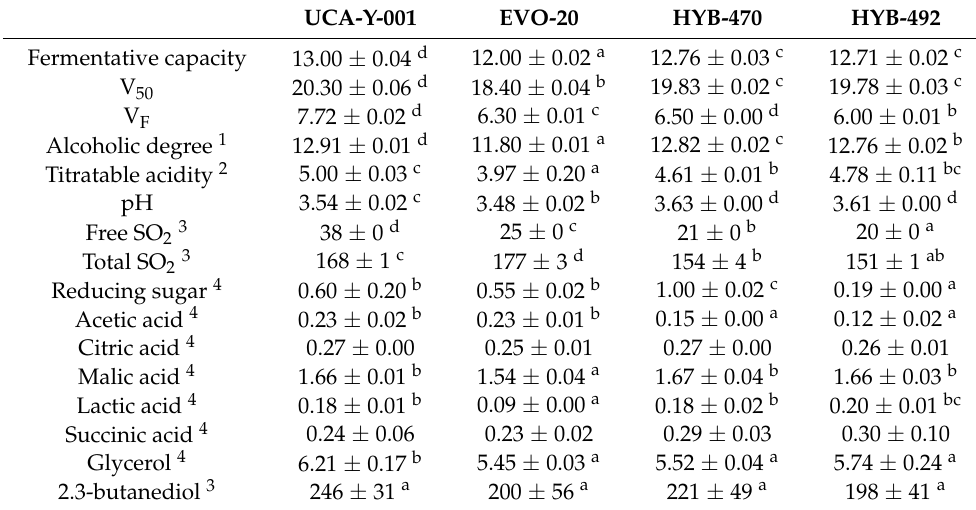
Table 2. Oenological parameters (mean value ± standard deviation, n = 3) of Palomino Fino white wines fermented with the different yeast strains analyzed at an industrial